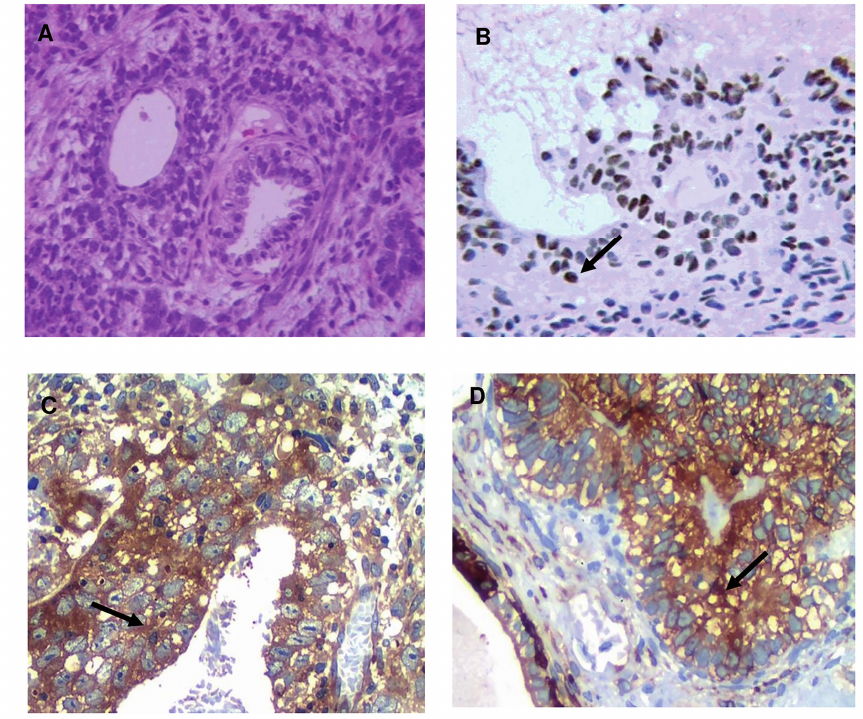
Figure 1 - Representative images of H&E and immunostaining for the tumor markers (x400): A) H&E of non-seminoma testicular Tumor. Arrows indicate immunopositivity for: B) ERCC1; C) NF -κ B; D) TG2.